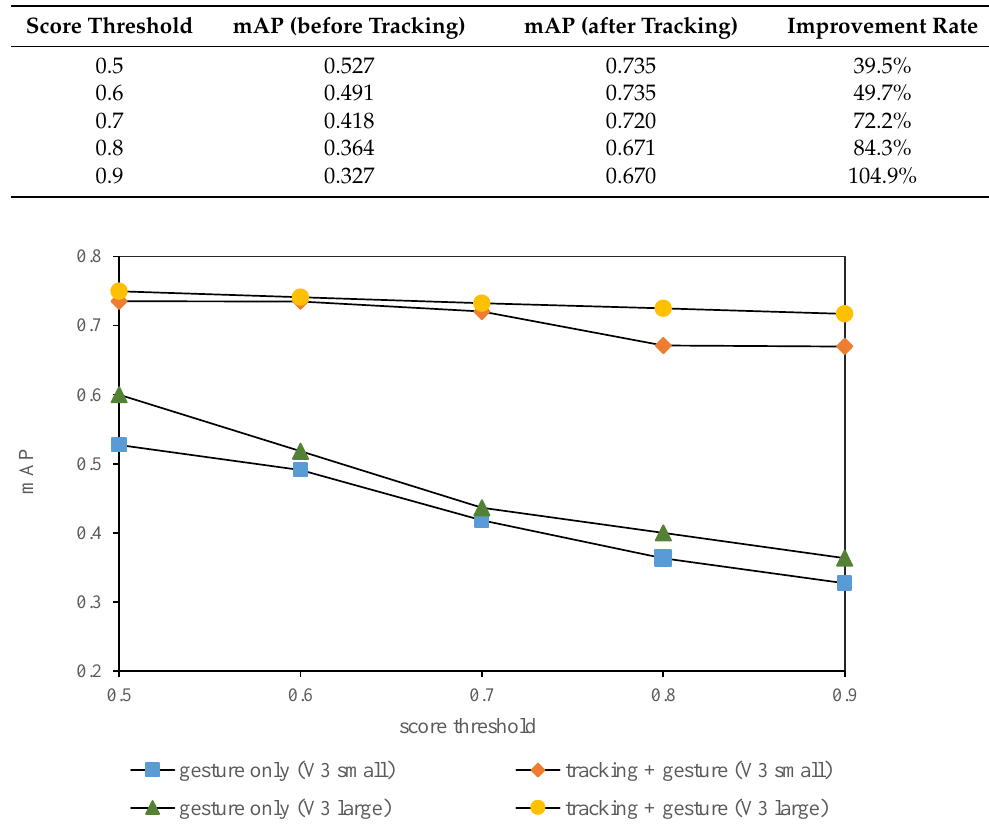
Figure 12. With the increase of the score threshold, the gesture recognition accuracy before and after human tracking. Blue and green lines represent the results before tracking, red and orange lines represent the results after